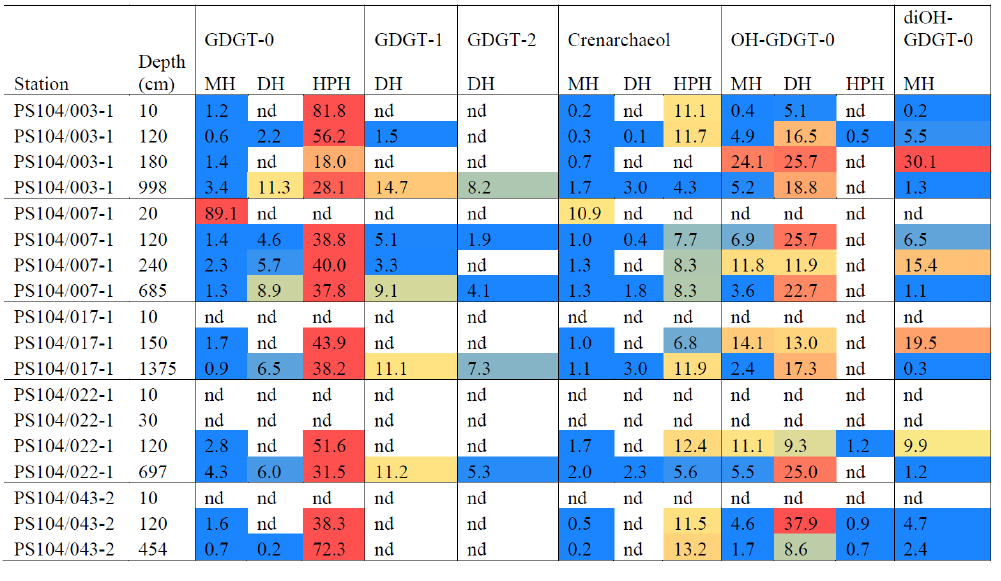
Table 3. Relative abundances (%) and heat map of IPLs identified in Amundsen Sea. Relative abundances > 30% indicated in red, low